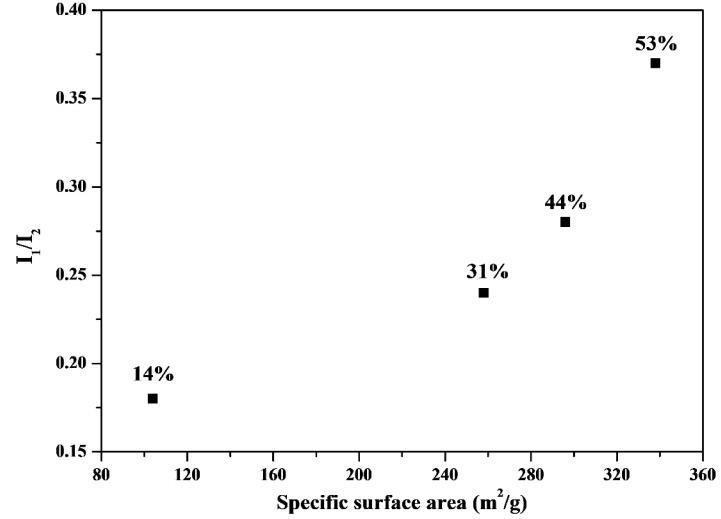
Figure 6. Comparison of I 1 /I 2 (bioactivity) and surface area for various surfactant concentrations treated MBG. The values of surfactant concentration are